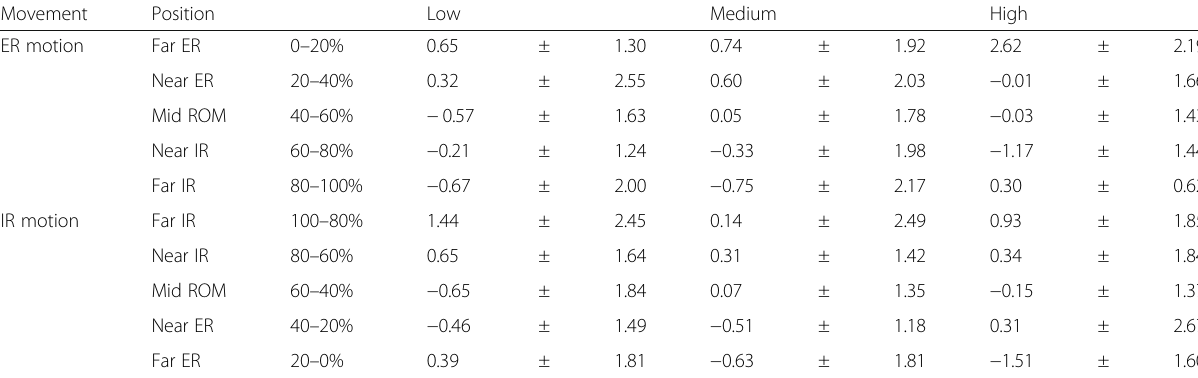
Table 2 Anterior translation of the humeral head from the center of the glenoid fossa at every 20% of the rotation cycle (mean ± SD mm) Movement Position Low Medium High